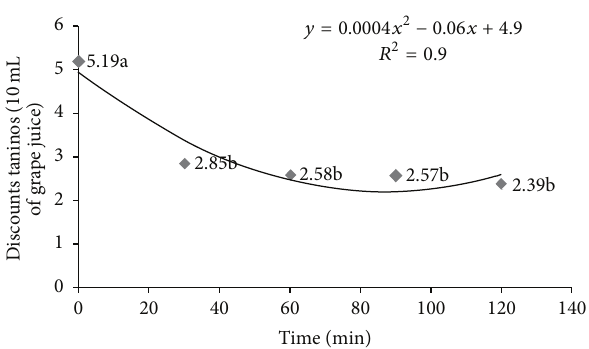
Figure 6: Effect of 2mL tannase on degradation present in grape juice at different times. Values on the 𝑌 -axis represent the amount of tannins in the